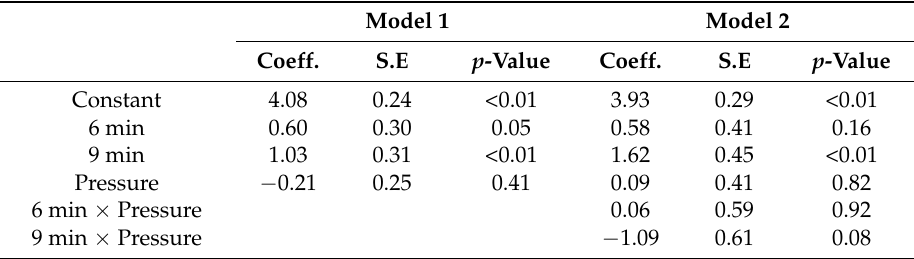
Table 3. Results of regression